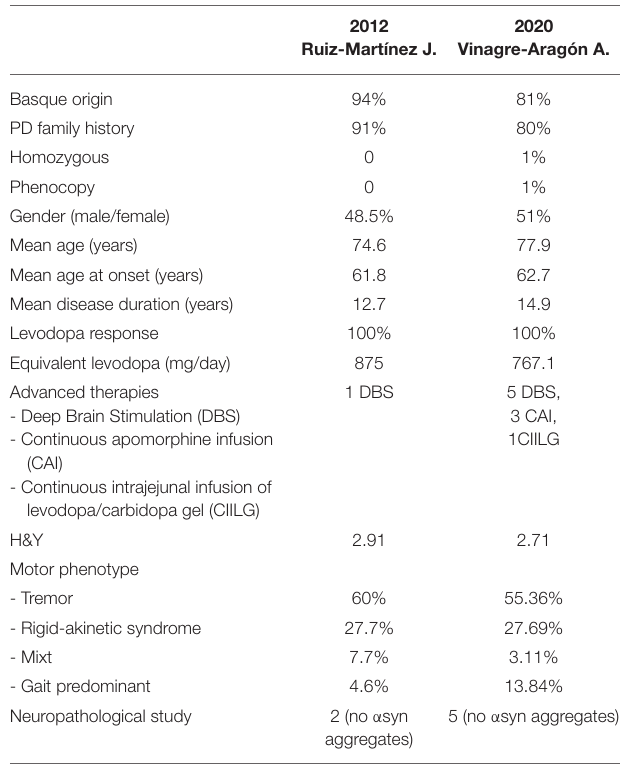
TABLE 1 | Characteristics of the R1441G-PD patients in 2012 and updated date about the current cohort.